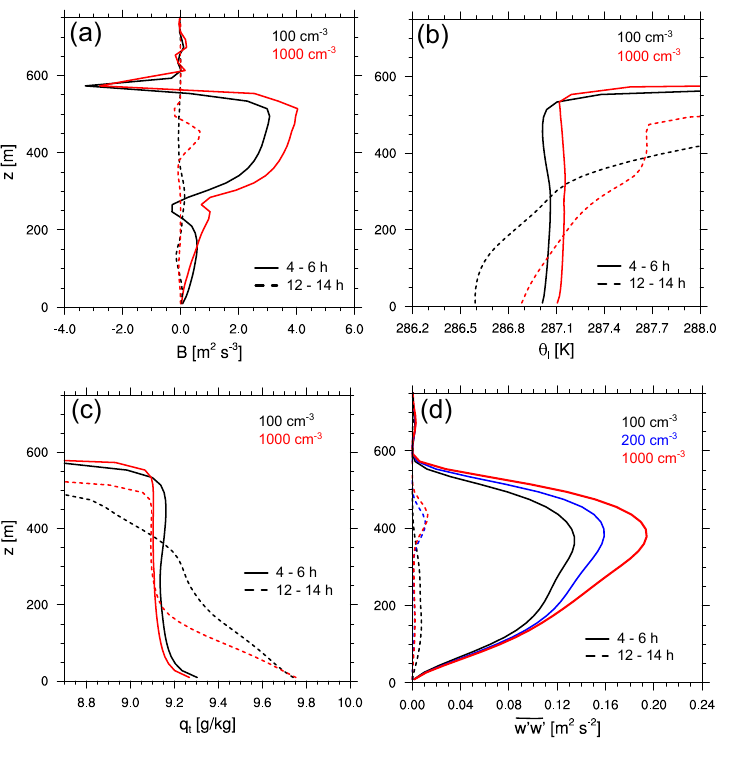
w 0 θ v 0 × 10 − 4 , where θ v θ v